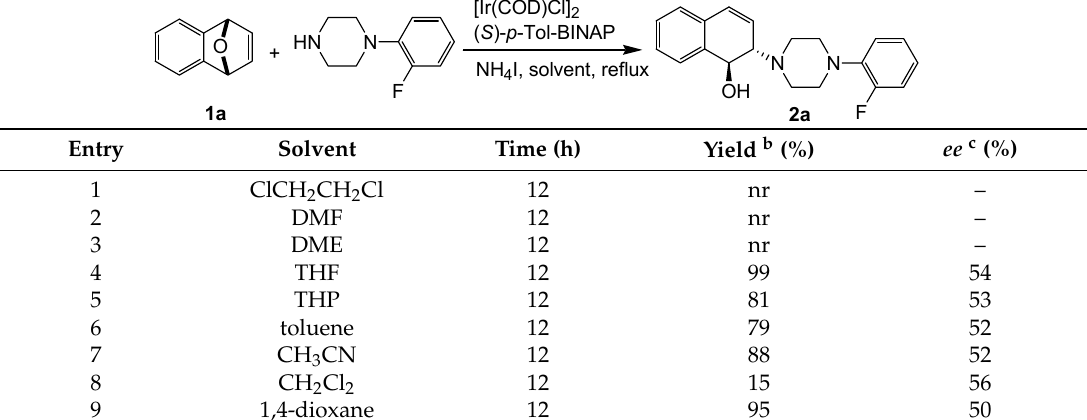
Table 2. Effects of solvent on the ring-opening a .